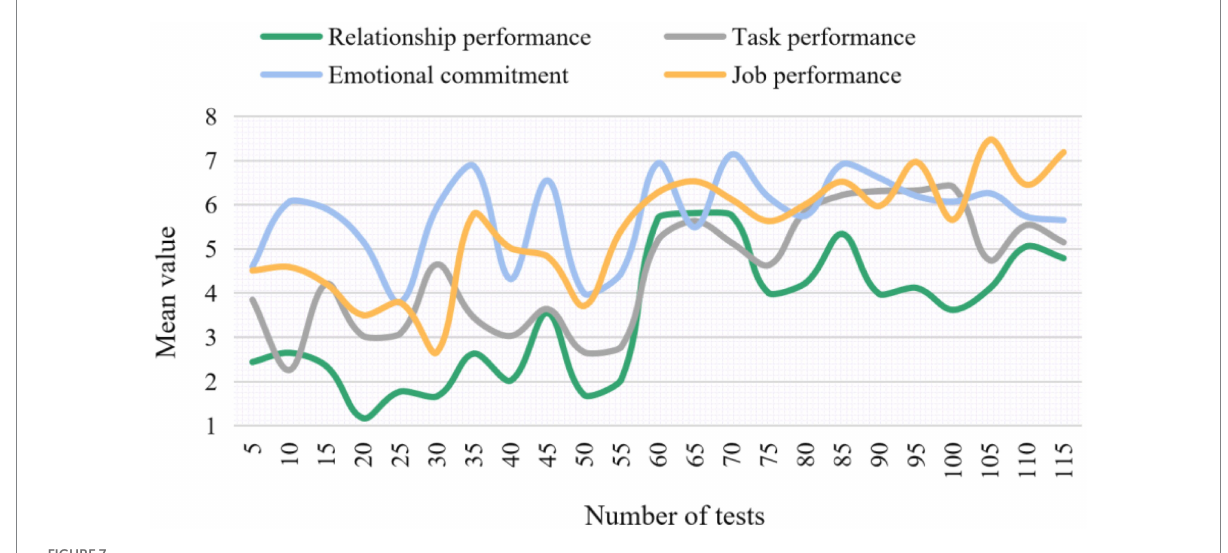
FIGURE 7 Mean change under different items.